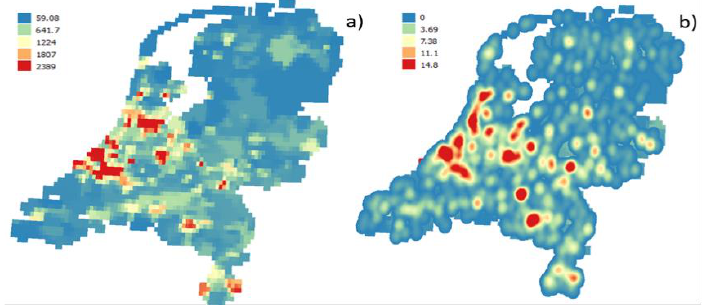
Figure 6. Raster layers of ( a ) population density in the Netherlands, and ( b ) public chargers density distribution in the Netherlands.